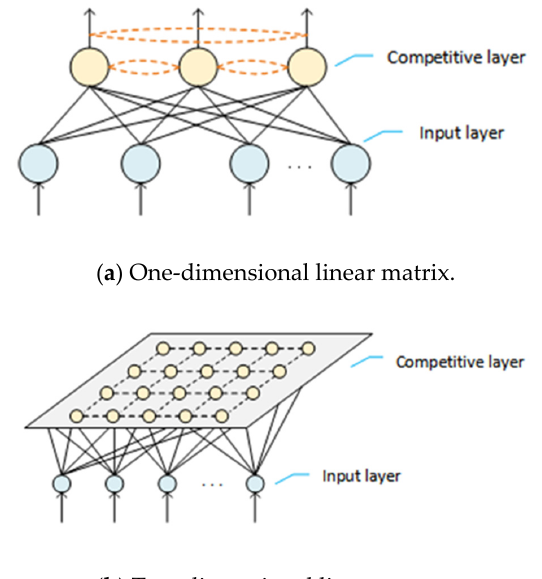
Figure 1. Kohonen neural network